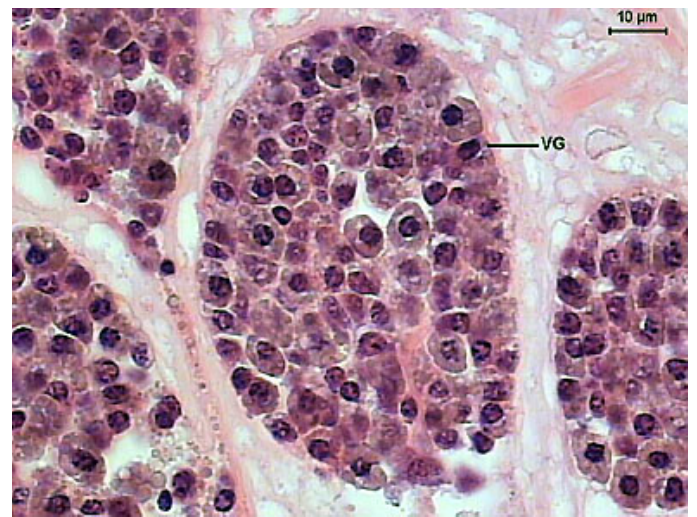
Figure 18. Detail of the Sticholecitha serpentis vitelline glands (VG). HE.